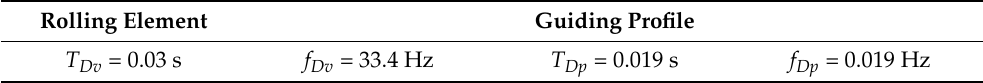
Table 2. Damage time periods and frequencies of Hiwin linear rolling system.